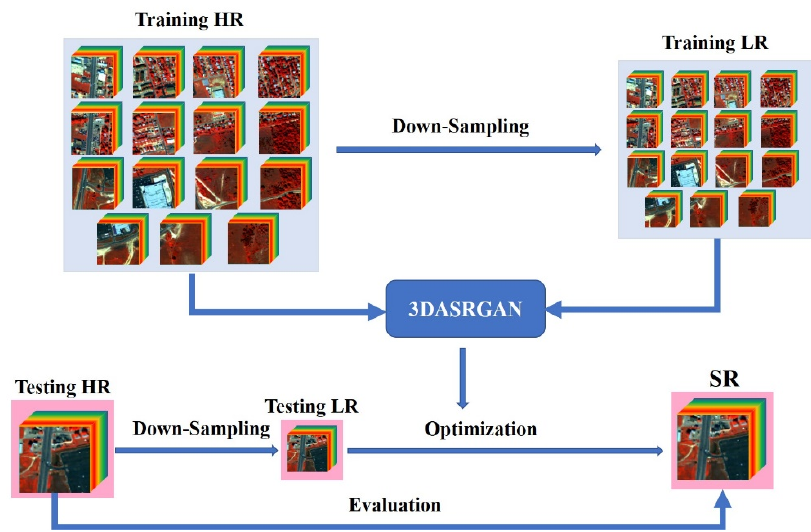
Figure 3. The framework of proposed three-dimensional Attention-based Super-Resolution Generative Adversarial Network (3DASRGAN) for SR of hyperspectral remote sensing images (HSIs).